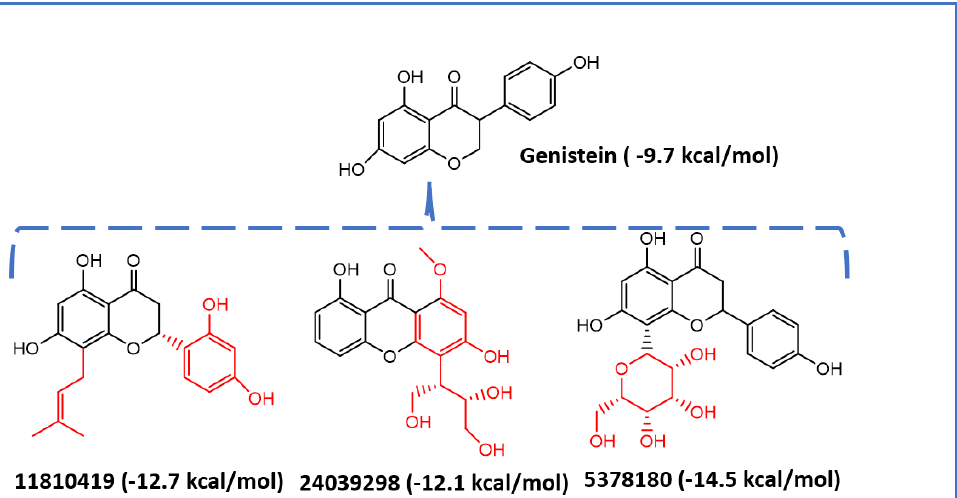
Figure 6. Structural diversity of new isoflavoids as potential Mps1 kinase inhibitors. The number in brackets corresponds to the Glide score.